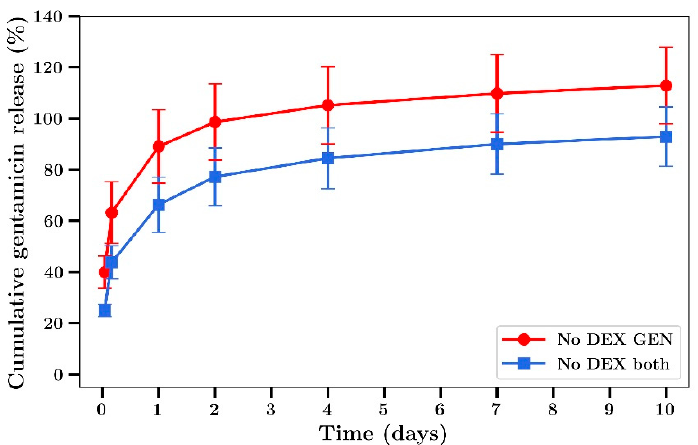
Figure 7. Time course of gentamicin release from Palacos bone cement films (no dextran) loaded with gentamicin alone or gentamicin plus Ag. (Silver loaded at 0.8% and gentamicin at 0.8% w/w ) ( n = 4).